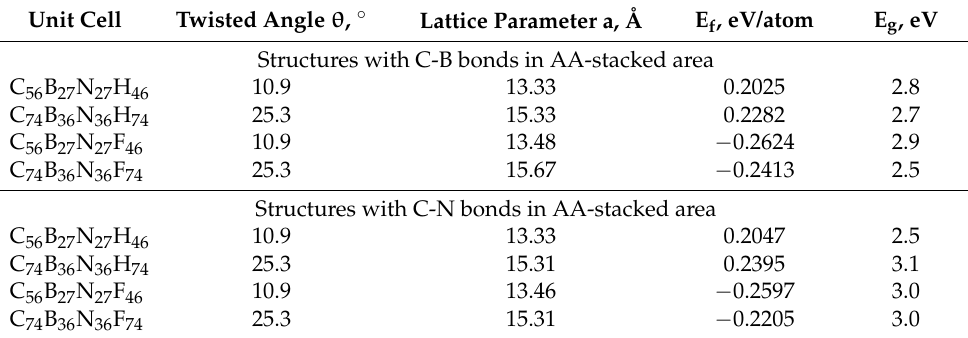
Table 2. Parameters of considered G/BN diamane-like structures. Unit Cell Twisted Angle θ , ◦ Lattice Parameter a, Å E f , eV/atom E g , eV Structures with C-B bonds in AA-stacked